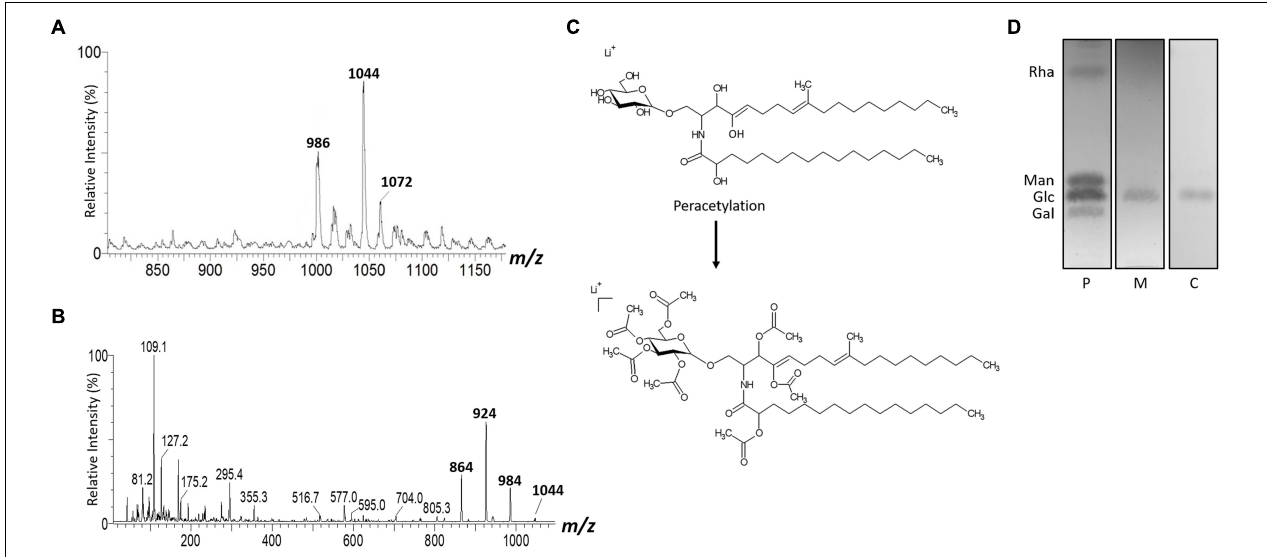
FIGURE 2 | ESI-MS1 (A) and MS2 (B) of the peracetylated GlcCer species ( m/z 1044) from mycelium form. The assignment proposed for native ( m/z 750) and peracetylated GlcCer species ( m/z 1044) from L. prolificans (C) . HPTLC of the monosaccharide constituent of GlcCer (D) .